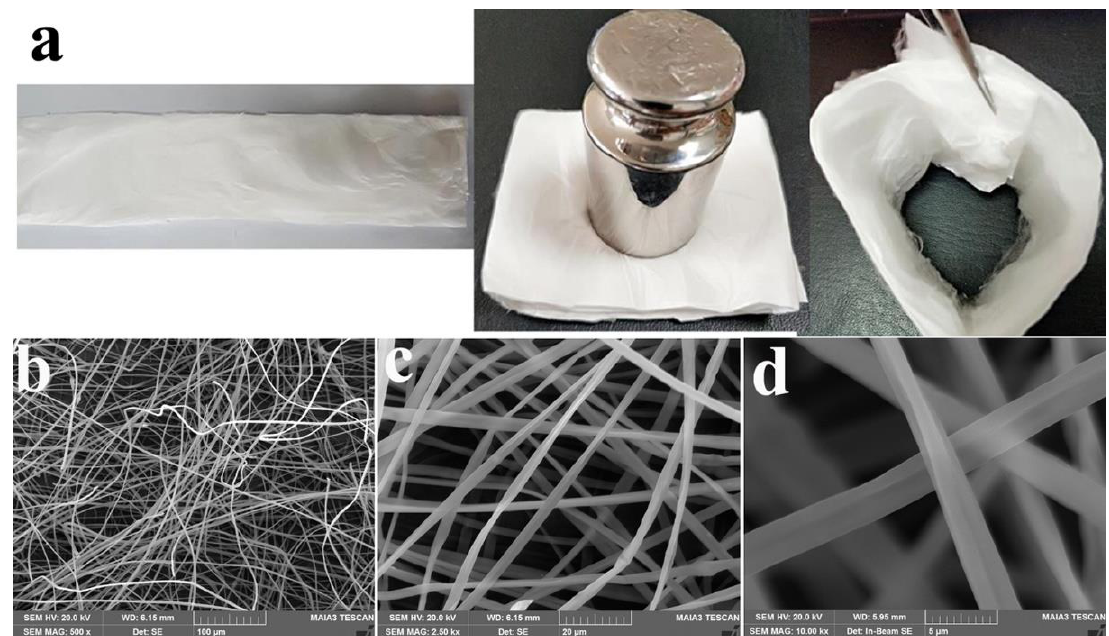
Figure 9. ( a ) Optical photographs showing the as-spun RSCA fibrous membrane. ( b – d ) SEM images of RSCA fibrous membrane.